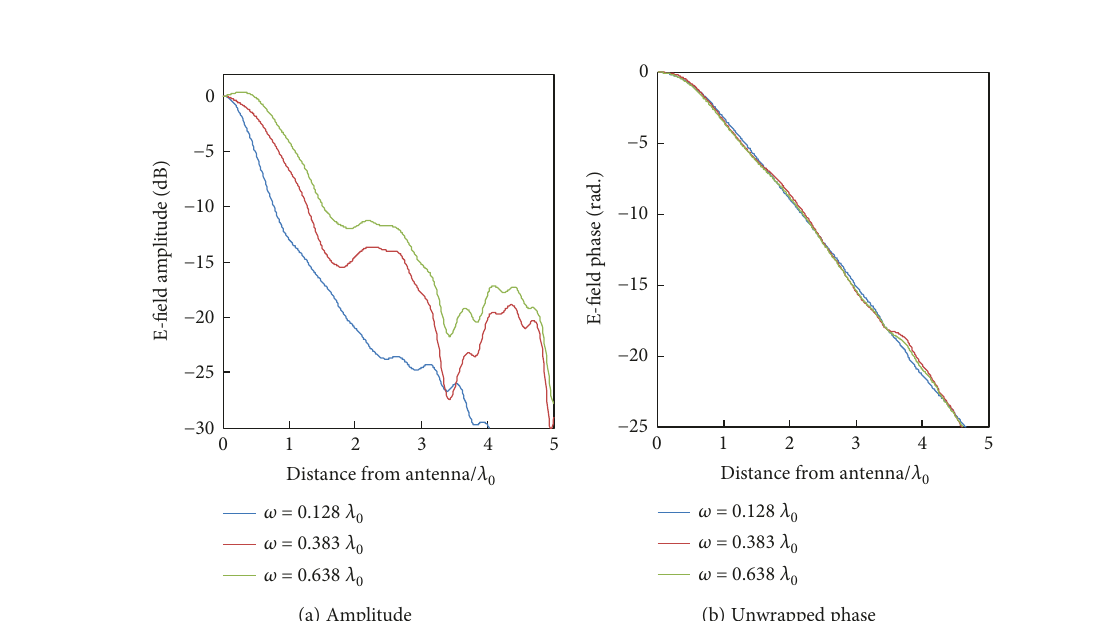
Figure 15: Normalized e- fi eld intensity distribution for defected corrugated